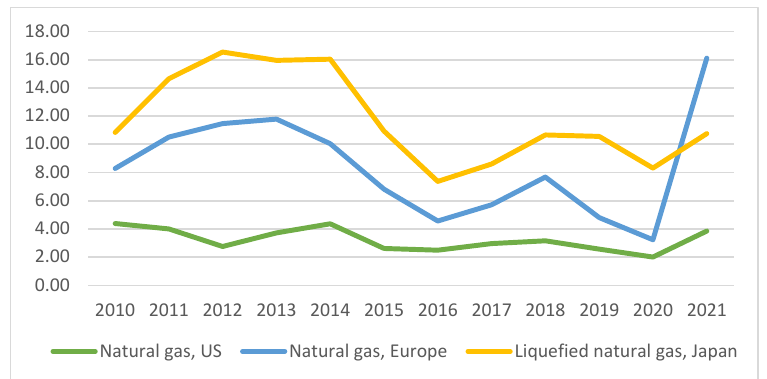
Figure 2. Lique fi ed Natural Gas Price (USD/mmbtu) [19]. Figure 2. Liquefied Natural Gas Price (USD/mmbtu)